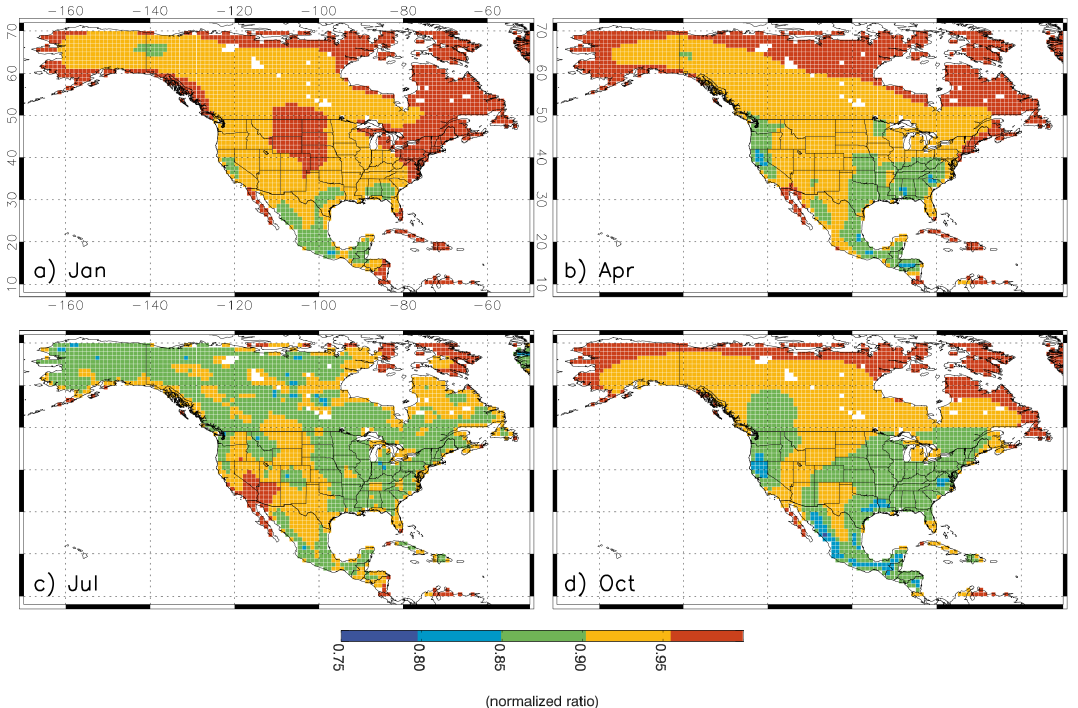
Figure 11. Ratio of the posterior uncertainty for the 2 × prior inversion to that for the standard inversion, normalized by a factor of 2 for case 1 in (a) January, (b) April, (c) July, and (d)